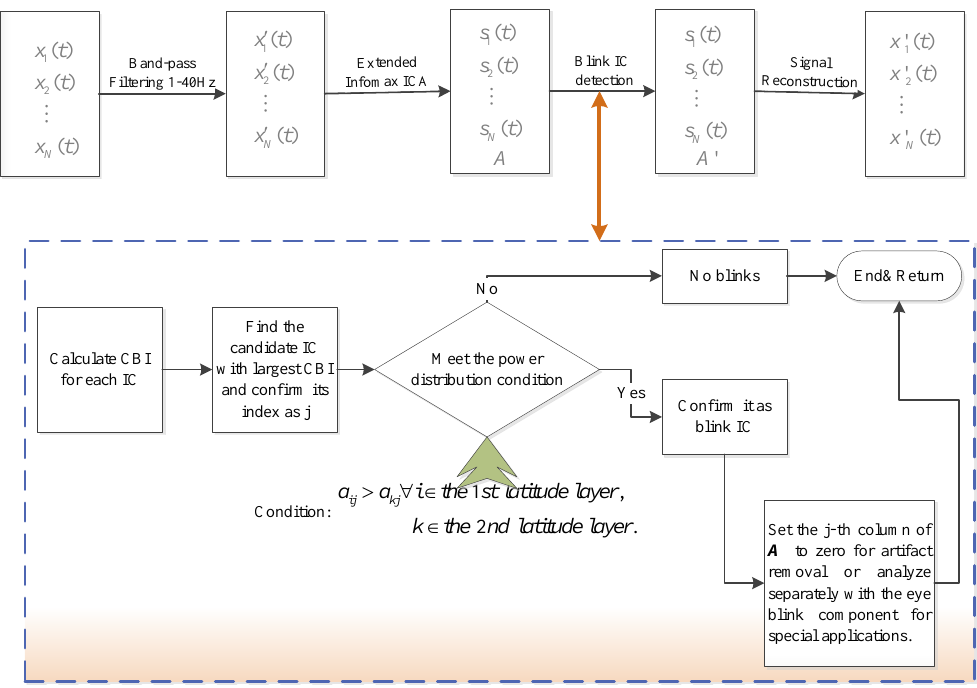
Figure 2. Principle diagram of the proposed